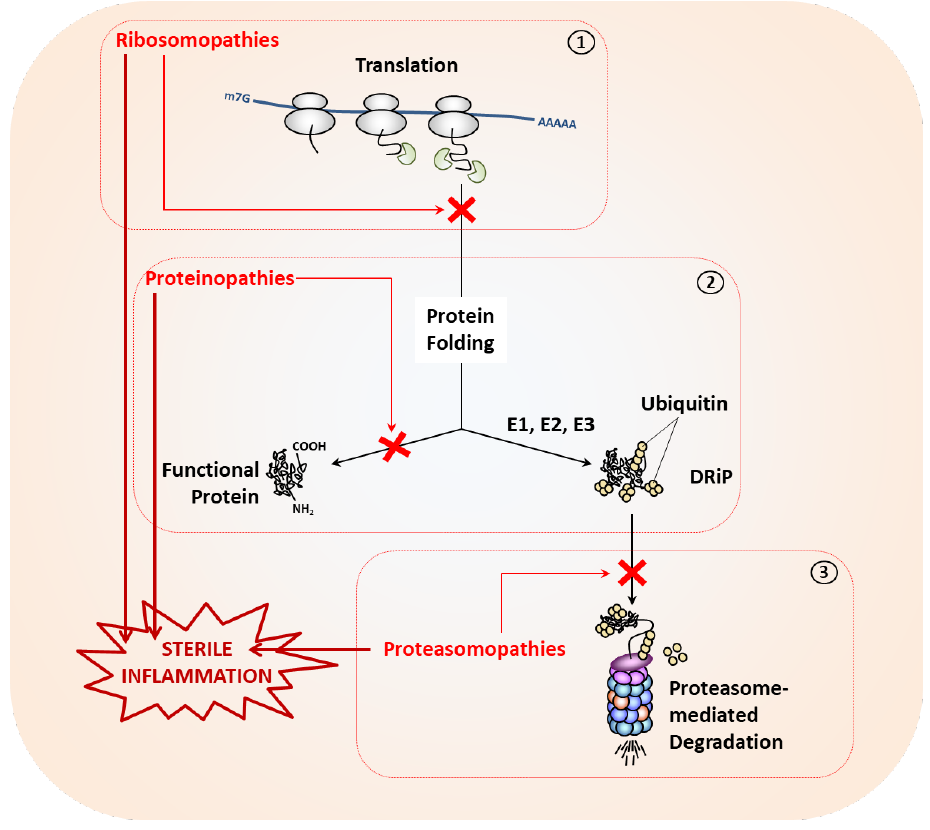
Figure 2. Proteostasis perturbations may arise at any stage of the protein life cycle and typically result in the initiation of sterile inflammation. Depicted are three pathological situations causing impaired proteostasis in which translation ( 1 ), protein folding ( 2 ) and proteasome-mediated protein degradation of defective ribosomal products (DRiPs) following their polyubiquitination by E1, E2 and E3 enzymes of the ubiquitin-conjugation pathway ( 3 ) are affected.